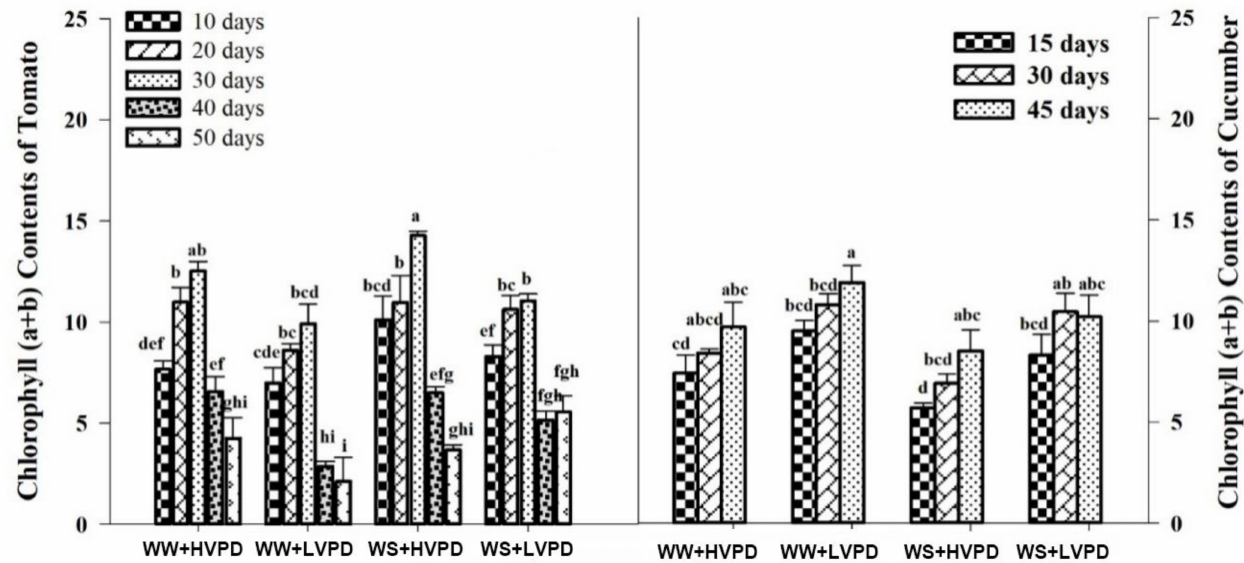
Figure 7. Effects of VPD and soil moisture on the chlorophyll contents of tomato plants. Data are pre- sented as mean ± standard error ( n = 10). Letters represent significant differences between treatments. Different letters indicate significant differences ( p < 0.05). WW (well-watered, 100%FC) + HVPD (high vapor pressure deficit); WW (well-watered, 100%FC) + LVPD (low vapor pressure deficit); WS (water stress, 60%FC) + HVPD (high vapor pressure deficit); WS (water stress, 60%FC) + LVPD (low vapor pressure